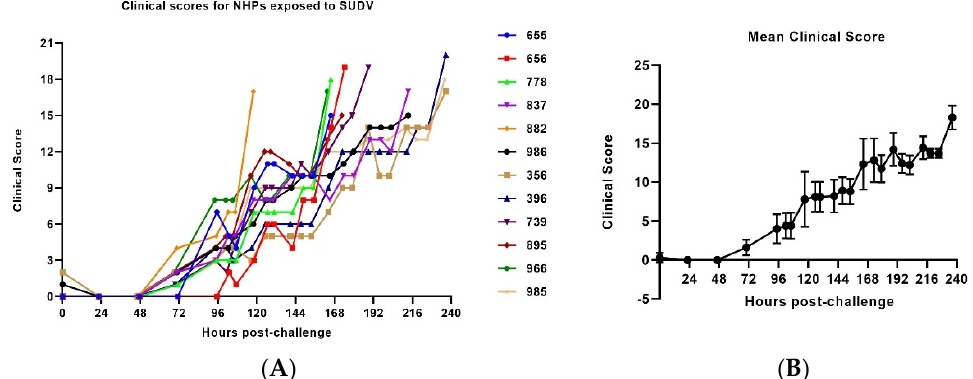
Figure 2. Clinical disease scores in SUDV-challenged NHPs. ( A ) Clinical disease score evolution of individual SUDV challenged animals throughout the infection. ( B ) Average clinical score evolution throughout the infection. (Day 0-Day 5 a.m.: n = 12 animals, Day 5 p.m.-Day 7 a.m.: n = 11 animals, Day 7 p.m.: n = 8 animals, Day 7 night-Day 8 a.m.: n = 6 animals, Day 8 a.m.-Day 9 a.m.: n = 5 animals, Day 9 p.m.-Day 10: n = 3 animals). The error bars represent the standard deviation (SD).